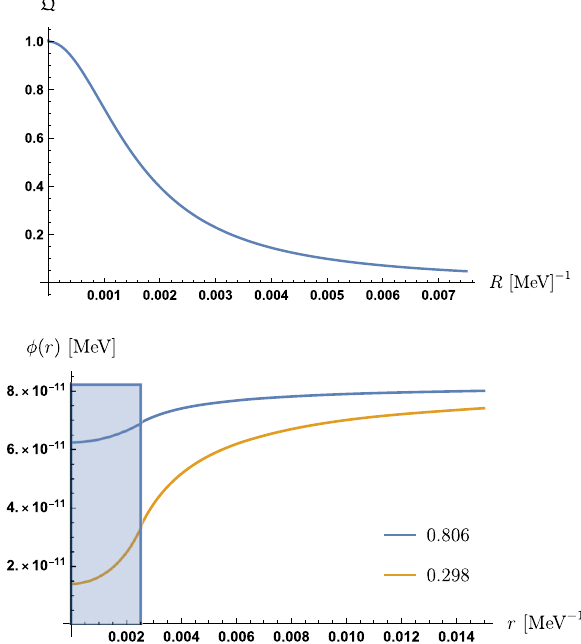
Fig. 4 Top: The “screening charge” Q is plotted as a function of the radius R ofasphere.Theparameterstakenare ρ N = 1 . 44 × 10 10 MeV 4 , the density of a neutron, A 2 = 10 40 , λ = 10 15 , V 0 according to Eq. (14) and R varying between 0 and 3 × R N = 0 . 0075 MeV − 1 , where R N is the radius of a neutron. Bottom: The field profile of a sphere (neutron) is plotted as a function of the radial distance of the center of the sphere with parameters A 2 = 10 39 , λ = 10 25 and V 0 according to Eq. (14). The blue line corresponds to the density of a neutron ρ N = 1 . 44 × 10 10 MeV 4 providing a “screening charge” Q = 0 . 806 and the yellow line to 10 × ρ N providing Q = 0 . 298. The blue square is bounded by the radius R N of the sphere (neutron) and the vacuum field value φ = φ